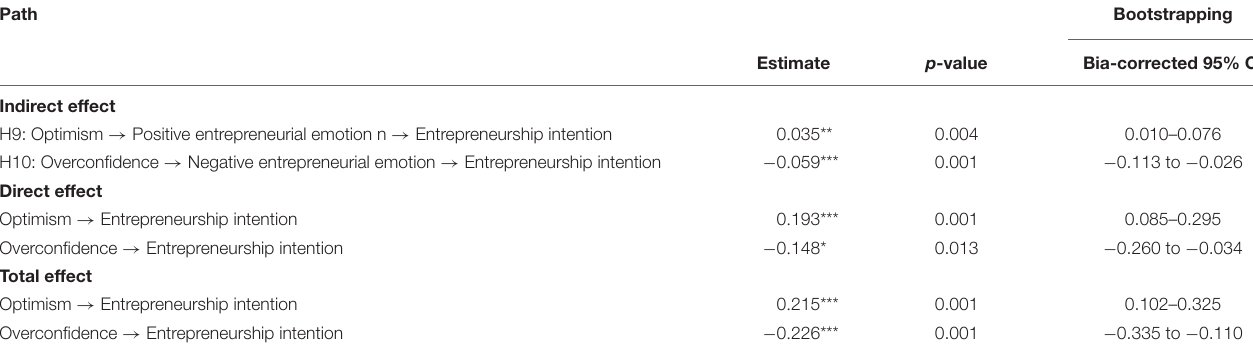
TABLE 4 | The multiple mediating effect